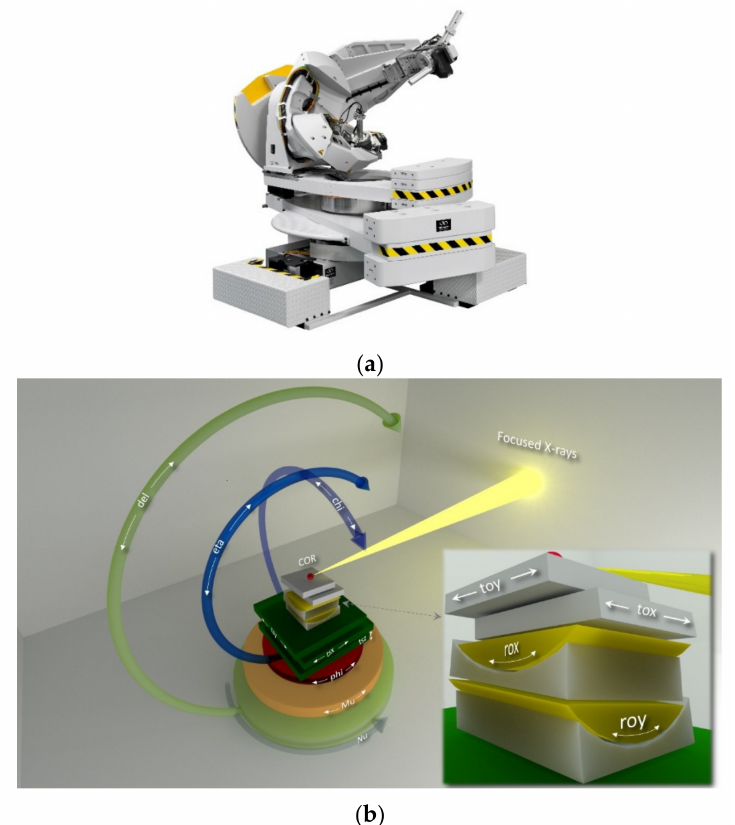
Figure 2. ( a ) The D2AM kappa diffractometer with the analyzer stage mounted on the detector arm. ( b ) The piled sample positioners, translations ( tsz , tsx and tsy ), and rotations ( Mu , phi , eta / chi ). The sample holder stage with the two translations ( tox , toy ) and cradles ( rox , roy ) are in the insert. The translations and the cradles are mounted on top of phi , itself, and mounted on the eta and chi rotations. All rotation axes go through the center of rotation (COR) of the diffractometer. The detector arm is connected to a vertical structure that rotates vertically along del and to a horizontal one that rotated along nu